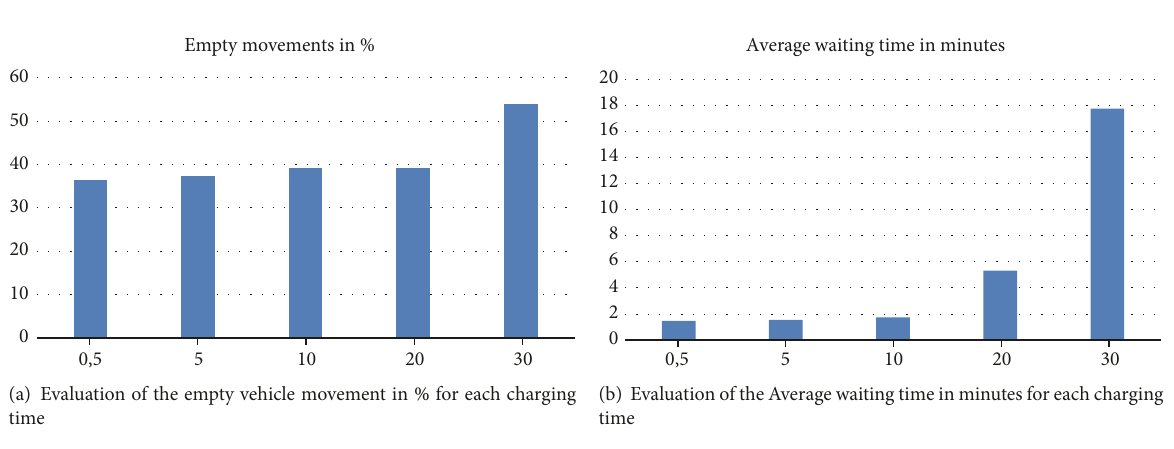
Figure 18: Pictures of the analysis of the charging